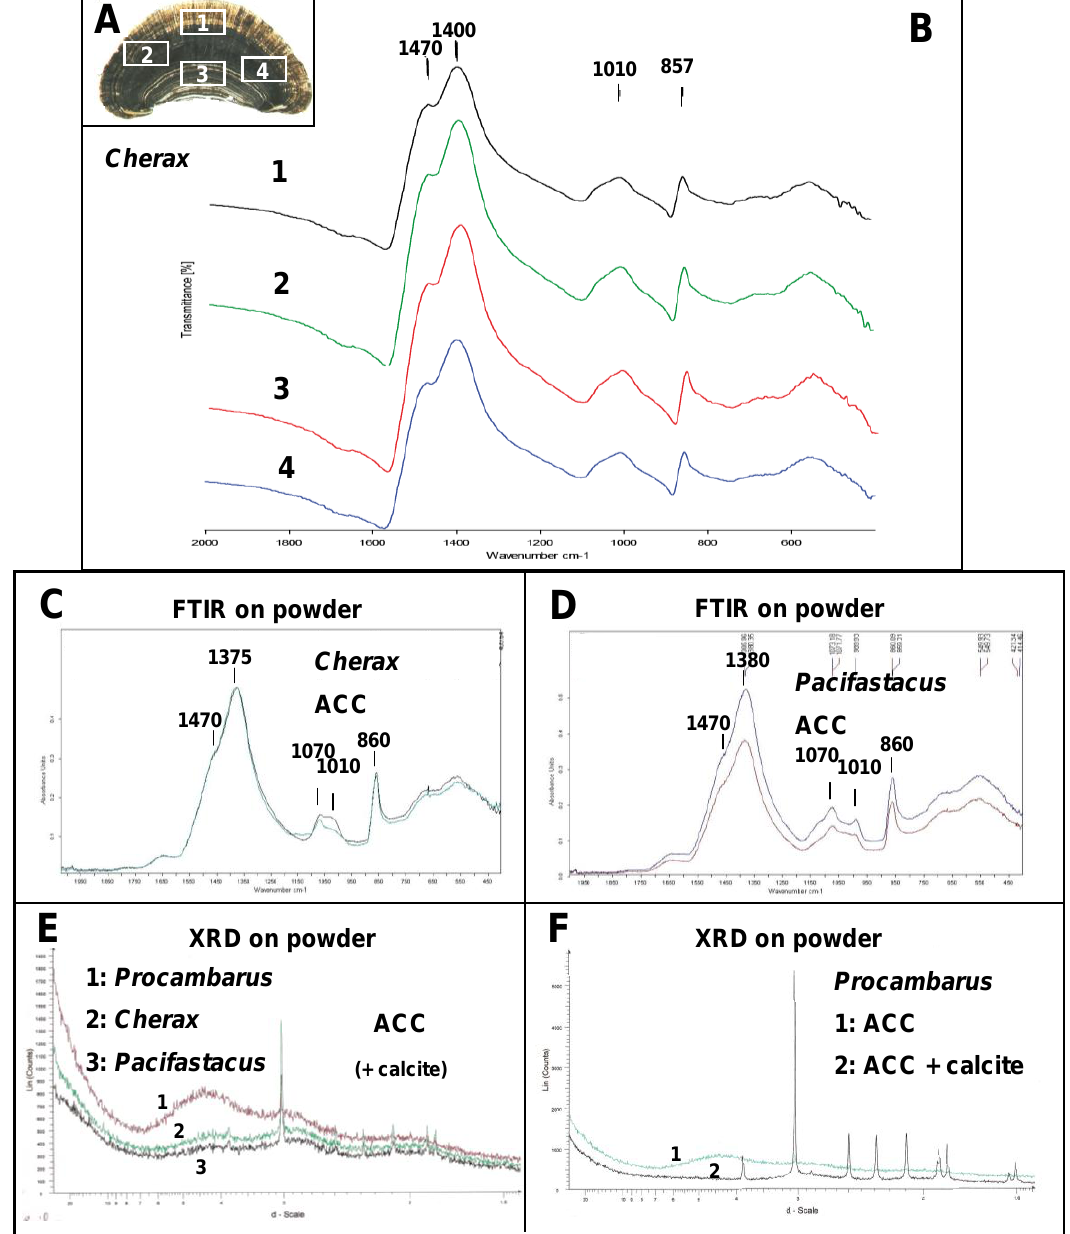
Figure 5. Analysis of the gastrolith CaCO polymorph by Fourier transform infrared 3 (FTIR) and XRD. A: Cross-section of a gastrolith from Cherax showing four different locations where FTIR analyses have been performed. B: FTIR spectra obtained from the 4 gastrolith areas shown in A. The four spectra are similar and are typical of the ACC polymorph. C–D: ACC FTIR spectra obtained on gastrolith powder from Cherax quadricarinatus (C) and Pacifastacus leniusculus (D). E–F: XRD spectra obtained on gastrolith powder (E) from three different species of crayfish and (F) from Procambarus clarkii (1. ACC polymorph profile, 2. ACC + calcite